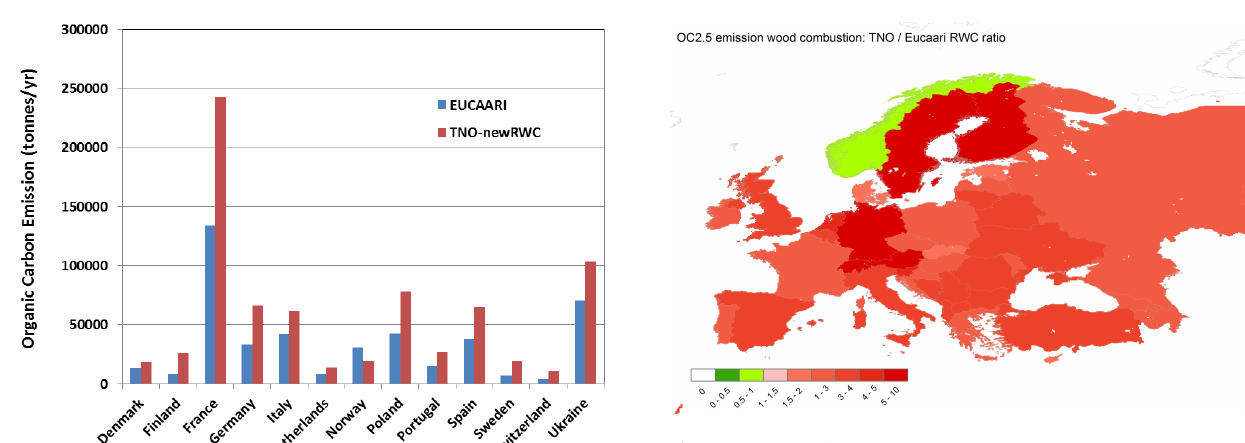
Figure 5. Ratio of the revised TNO-newRWC inventory relative to the previous EUCAARI OC emission